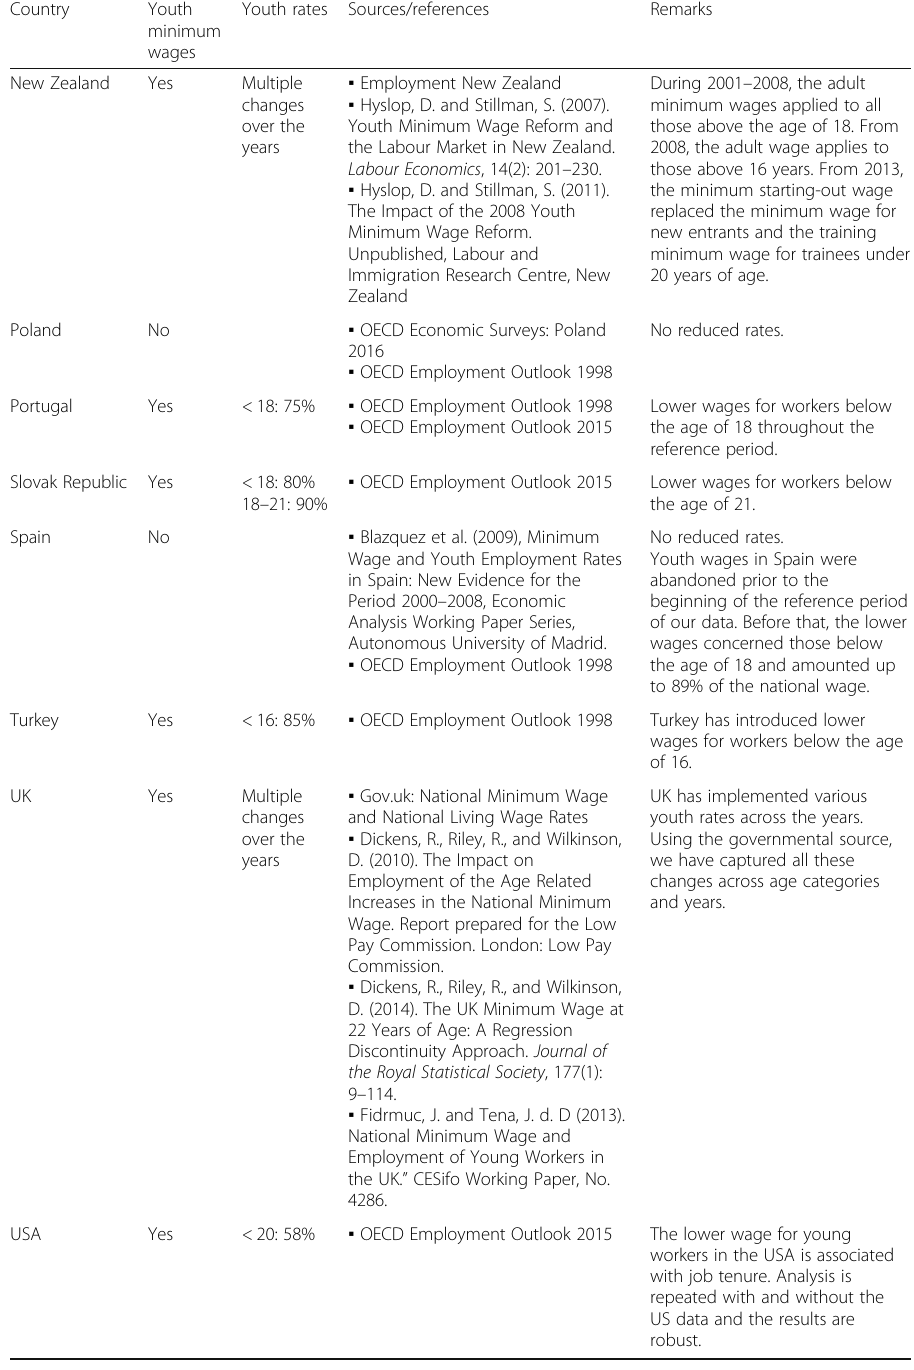
Table 6 Youth minimum wage systems for selected OECD countries (Continued)